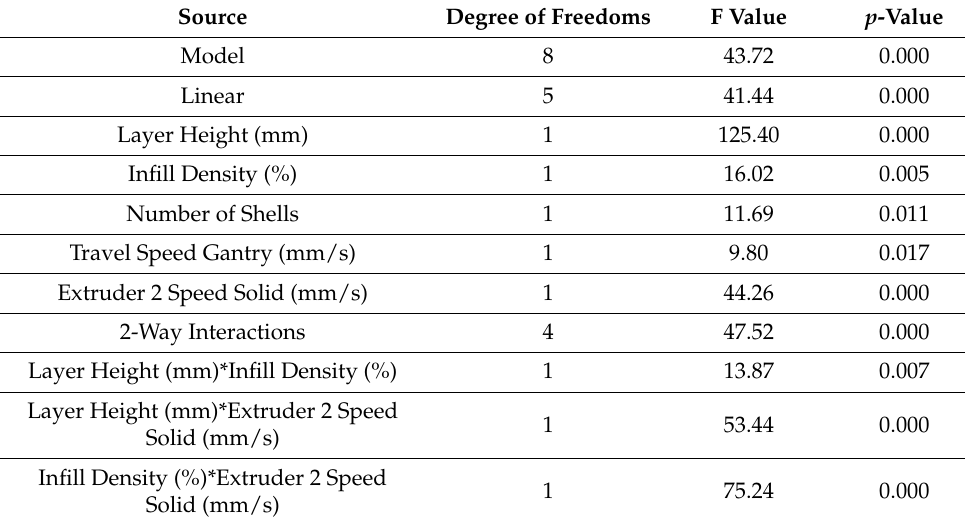
Table 3. ANOVA of the experimental